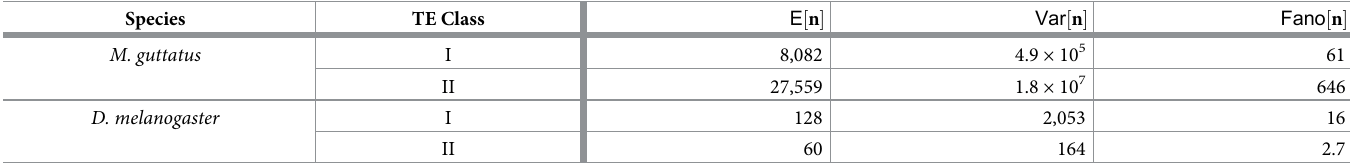
Mean, variance, and index of dispersion (Fano factor) of the population distribution of TE load in 164 M. guttatus and 131 D. melanogaster individuals (cf. Figs 1 and 2). Class I elements (retrotransposons) proliferate in a staged manner that involves an RNA intermediate, while Class II elements (DNA transposons) do not utilize an RNA intermediate (for review see Ch. 9 of